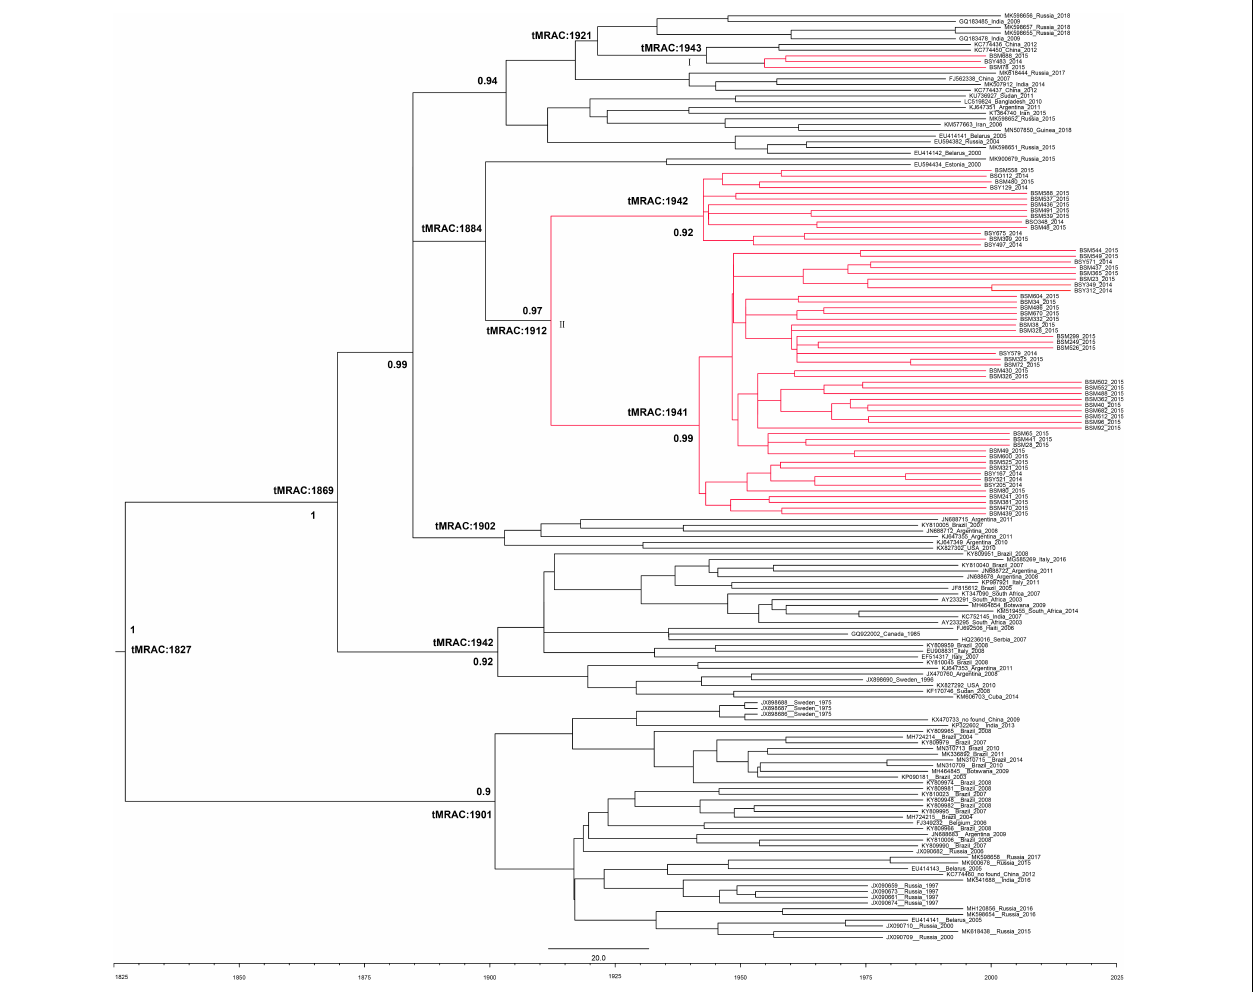
FIGURE 4 | Bayesian maximum clade tree of HBV-D3 partial P region sequences. Branches of Baisha sequences are colored red. The scale at the bottom of the tree represents years before the last sampling time (2015). All nodes marked with an asterisk show posterior probability > 0.90. The tree was automatically rooted under the assumption of a relaxed molecular